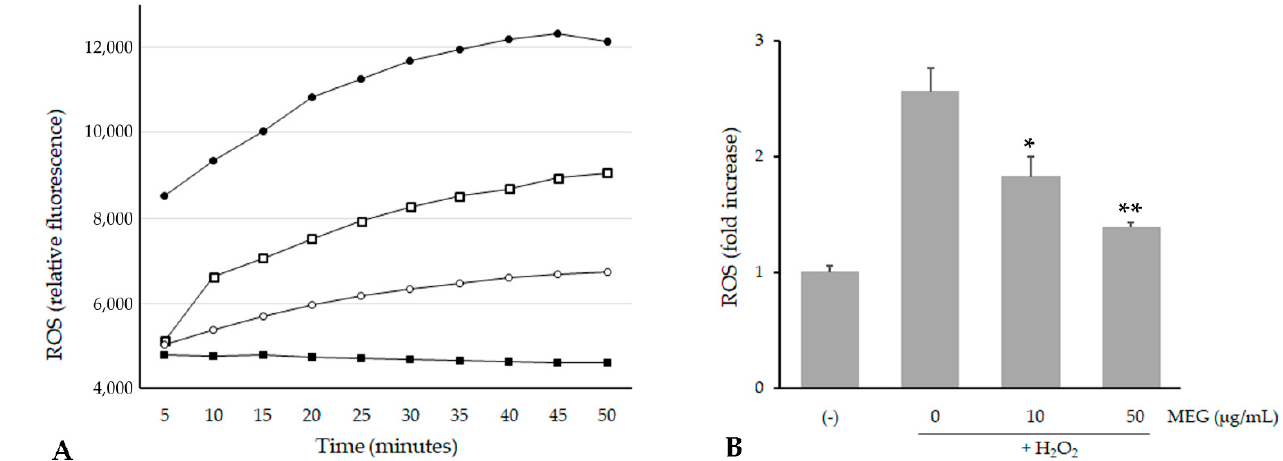
Figure 5. Inhibition of H 2 O 2 -induced reactive oxygen species (ROS) generation by MEG on HaCaT cells. ( A ) ROS levels (expressed as DCF fluorescence) in HaCaT cells pretreated with MEG and incubated with 1 mM of H 2 O 2 up to 50 min. ( ■ ): untreated cells, ( ● ): 1 mM H 2 O 2 , ( □ ): 10 µg/mL MEG + H 2 O 2, ( ○ ): 50 µg/mL MEG + H 2 O 2 . ( B ) Effect of MEG on ROS pro- duction in HaCaT cells after a 30 min treatment with 1 mM H 2 O 2 . Data (means ± SE) are normalized to untreated controls. * p < 0.01 and ** p < 0.001 compared to the H 2 O 2 treated group.